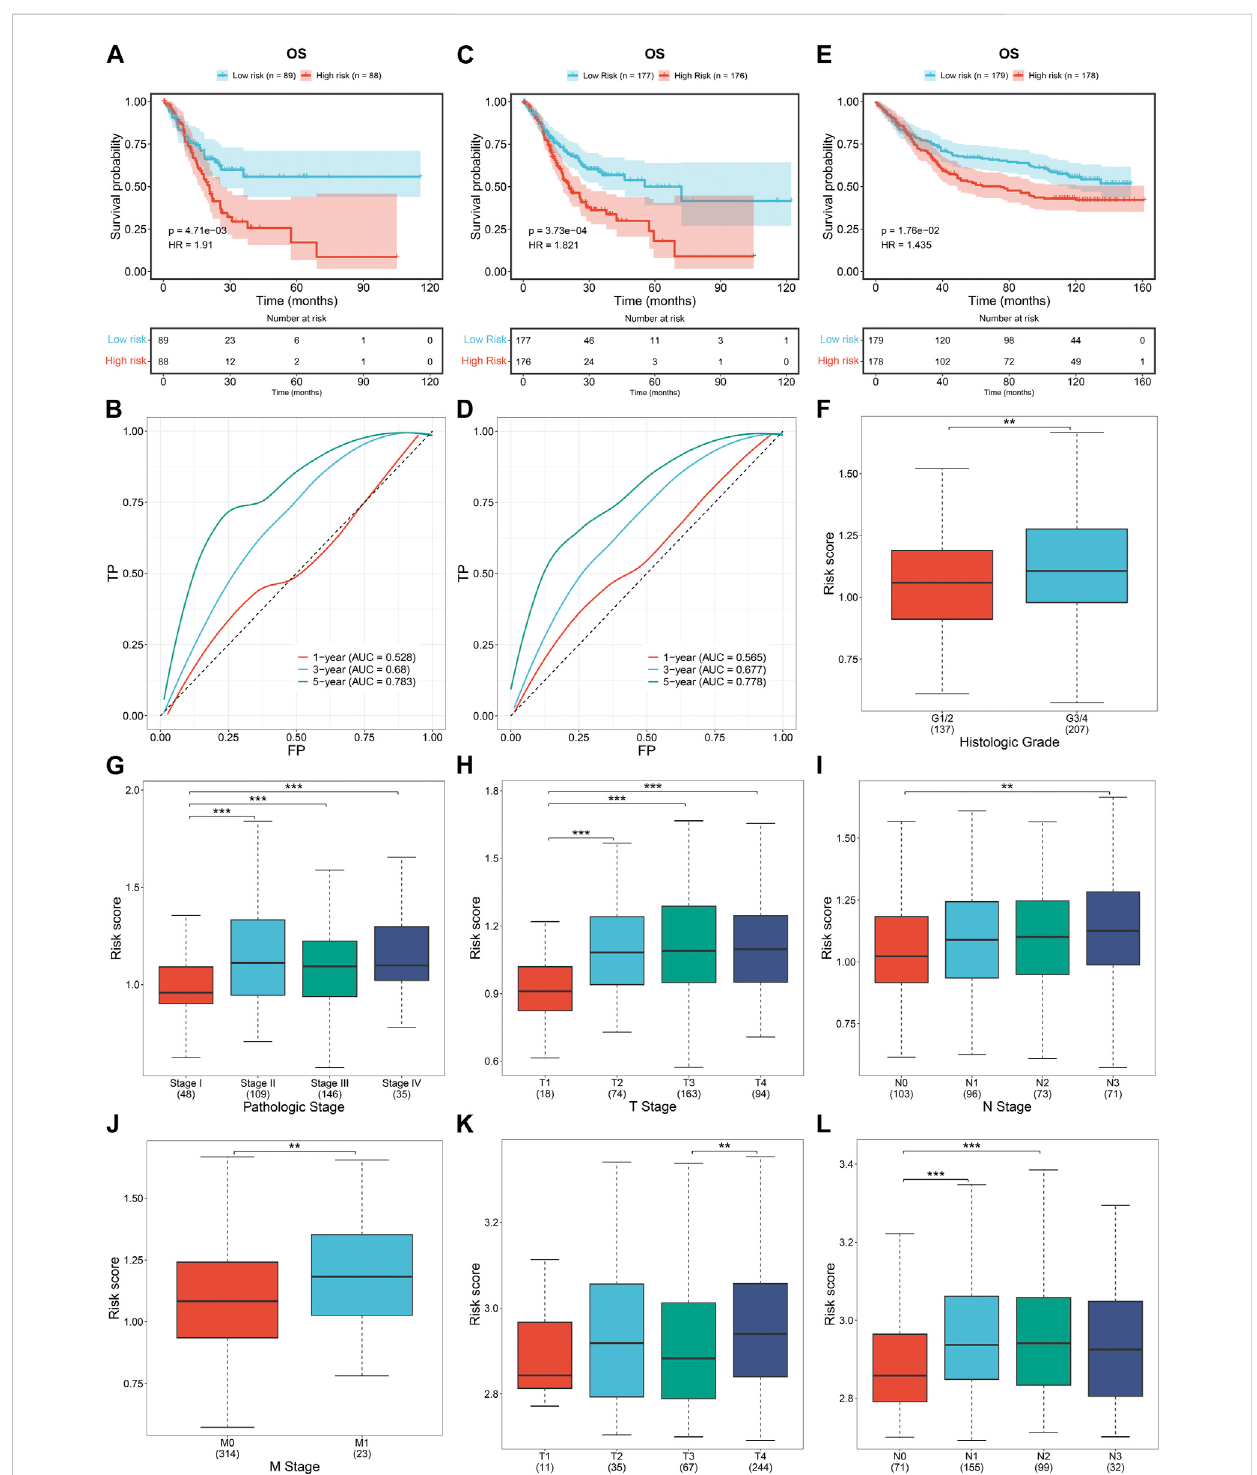
FIGURE 5 External veri fi cation of the DNA damage repair-relevant signature. (A,B) K-M curves of OS between low- and high-risk cases and ROC of survival status for this RiskScore in the test cohort. (C,D) K-M curves of OS between low- and high-risk cases and ROC of survival status for this RiskScore in the entire cohort. (E) K-Mcurves ofOS between low- andhigh-risk casesintheGSE84433 cohort. (F – J) Distribution ofRiskScore acrossdistincthistological grade, pathological stage, and T, N, M stage across TCGA-STAD. (K,L) Distribution of RiskScore across distinct T, N stage in the GSE84433